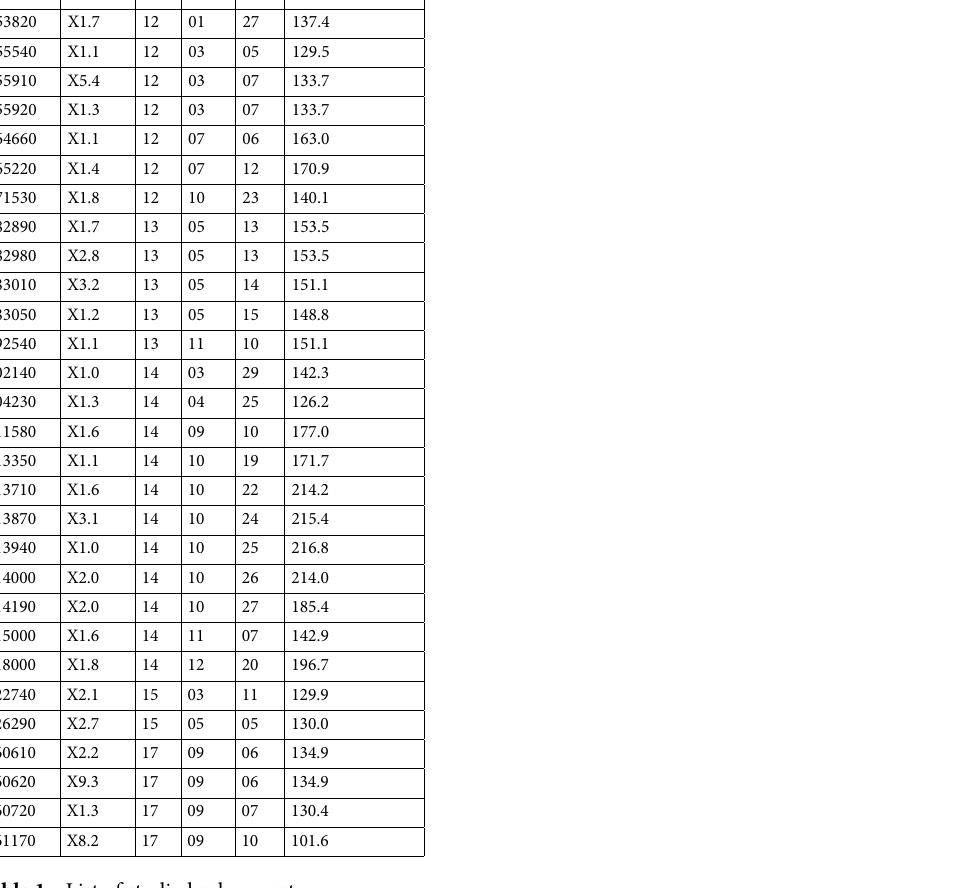
Table 1. List of studied solar